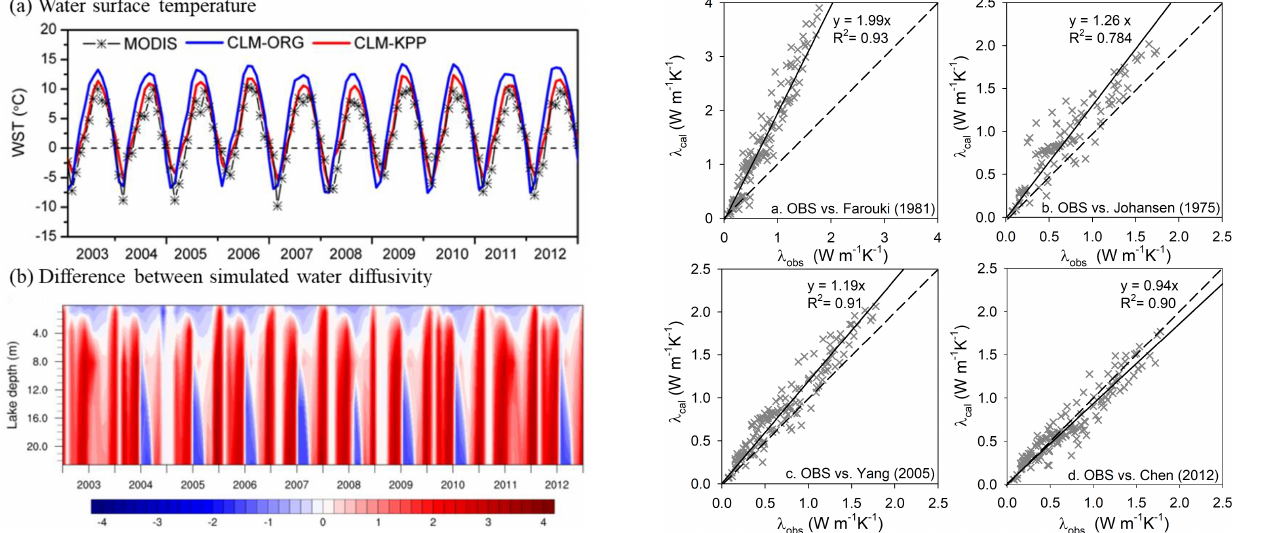
Figure 3. Scatterplots of laboratory-measured (OBS, shown on the x axis) and estimated thermal conductivity produced by the schemes of Farouki (1981) (a) , Johansen (1975) (b) , Yang et al. (2005) (c) , and Chen et al. (2012) (d) for four alpine grassland stations. The figure is reproduced from Chen et al.